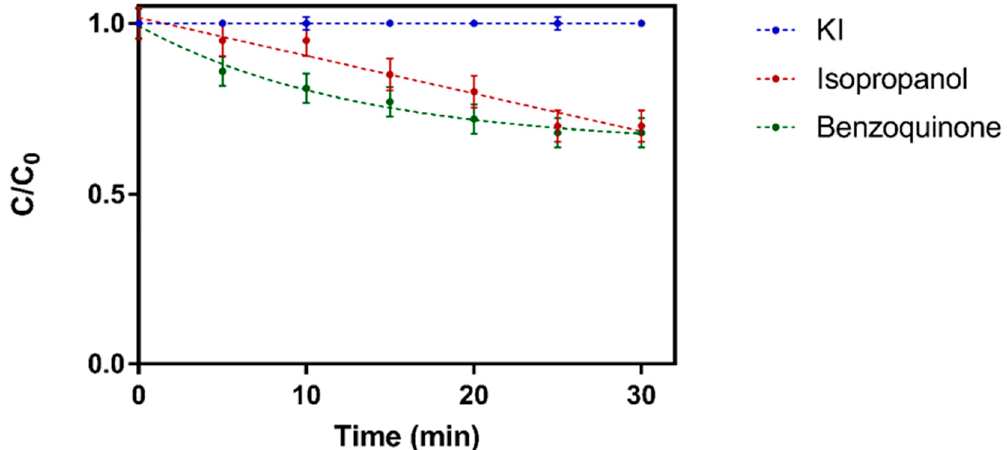
Figure 17. Zeroth order degradation plot for Atrazine given exposure to Cu-BiOCl photocatalysis in the presence of isopropanol, KI and benzoquinone and 254 nm light. Reused with permission from reference [137]. Copyright Elsevier 2018.